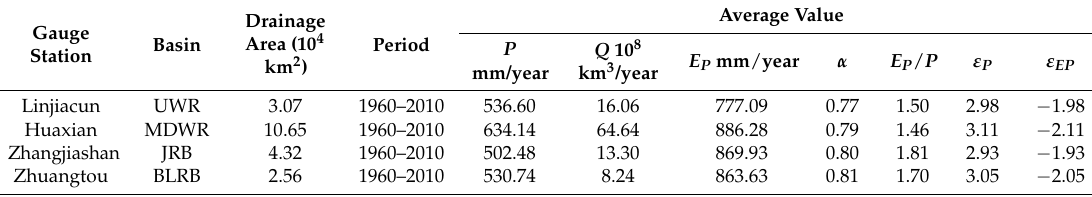
Figure 1. Location of the study area and hydro-meteorological stations. Table 1. Hydroclimatic characteristics of the Wei River Basin (WRB).